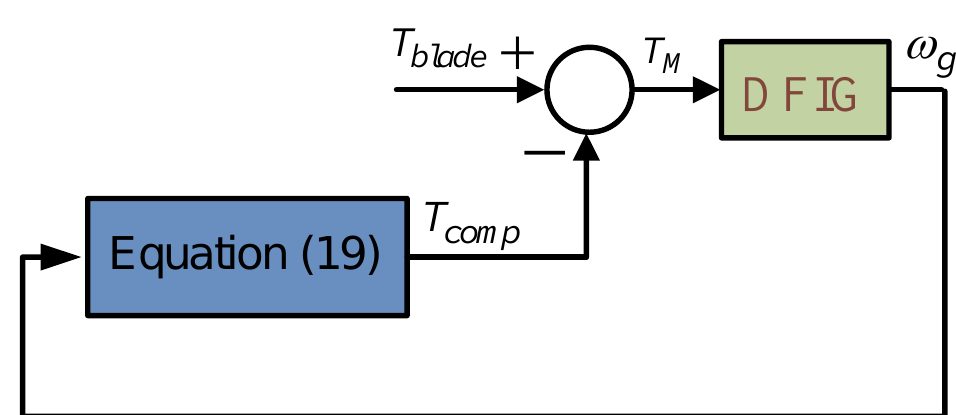
Figure 6. Torque compensation